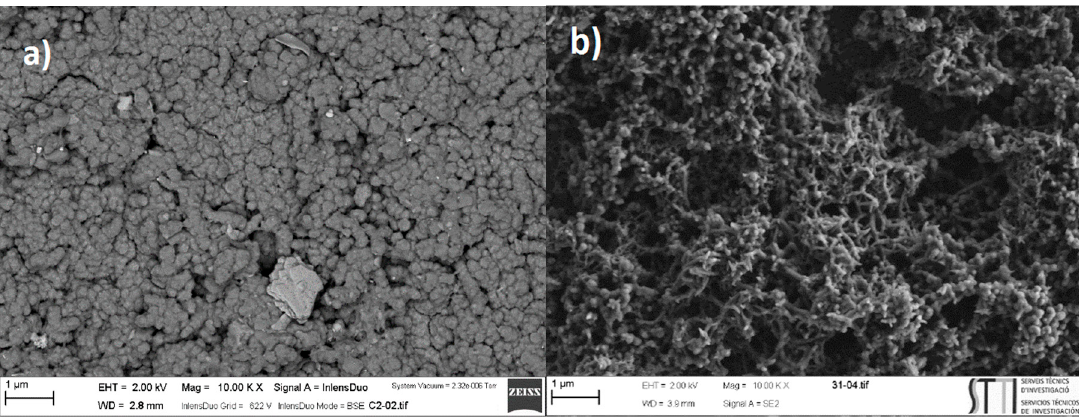
Figure 11. SEM micrographs of ( a ) GC/PANI(CV) electrode and ( b ) GC/PANI(PPP) electrode using 90 s of polymerization time.